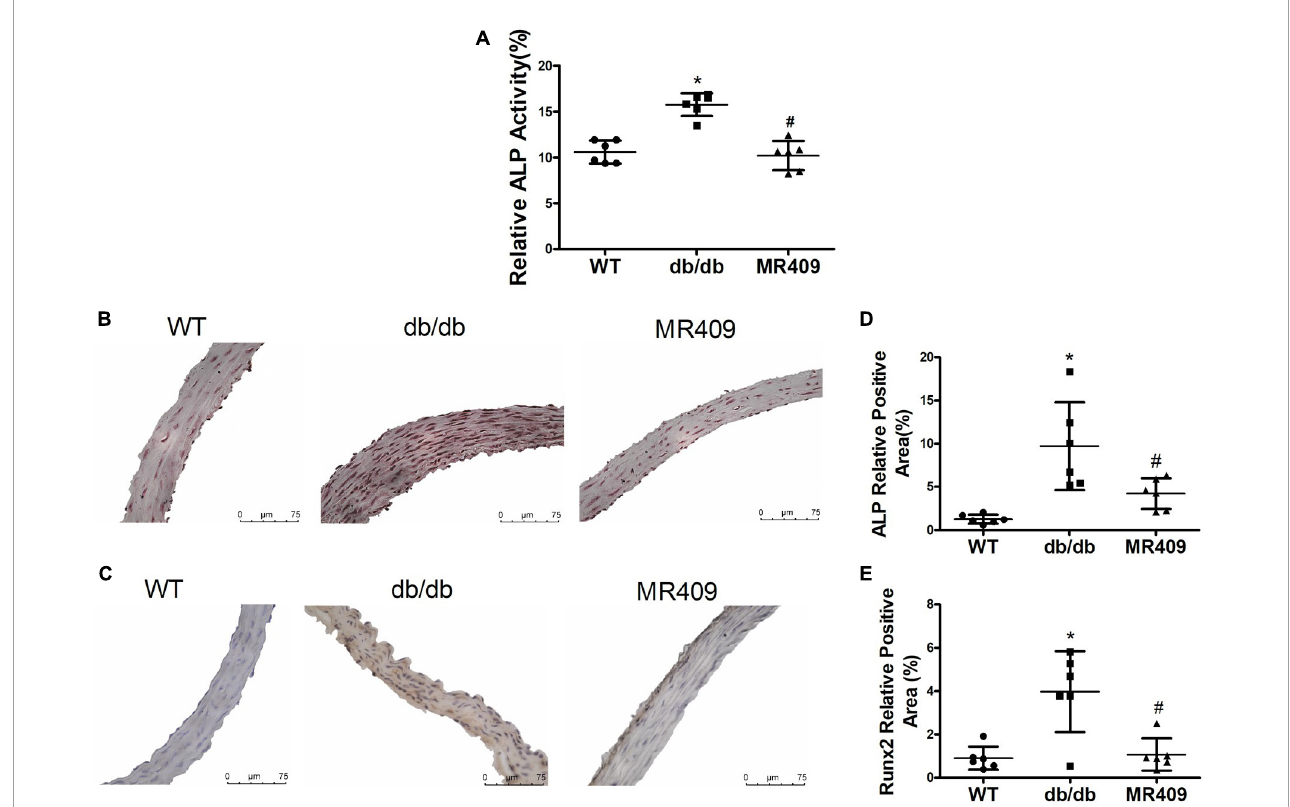
FIGURE6 Treatment with MR409 reduces serum alkaline phosphatase (ALP) activity (A) , the expression of ALP (B,D) and Runx2 (C,E) in the aorta of diabetic db/db mice. The representative images of ALP (B) and Runx2 (C) , were determined by immunohistochemistry, the quantitation of positive staining areas of ALP (D) and Runx2 (E) . N = 6, * p < 0.05 diabetic mice vs. WT mice, # p < 0.05 MR409 treated mice vs. diabetic mice.